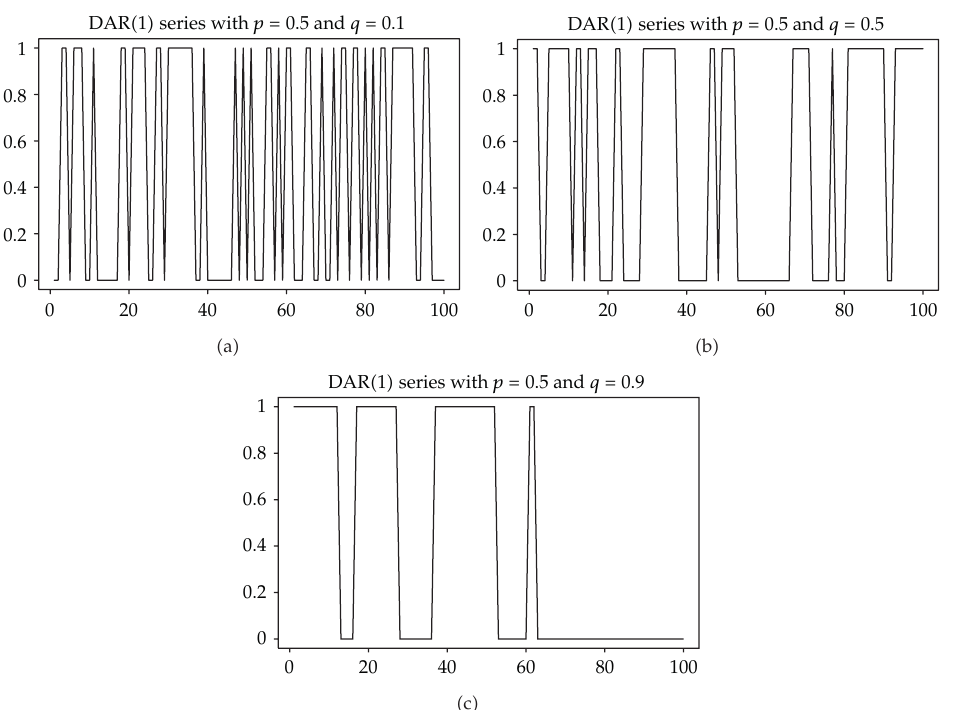
Figure 2: Simulated stationary DAR (cid:2) 1 (cid:3) models with p (cid:7) 0 . 5 and q (cid:7) 0 . 1 (cid:2) a (cid:3) , q (cid:7) 0 . 5 (cid:2) b (cid:3) , and q (cid:7) 0 . 9 (cid:2) c (cid:3)